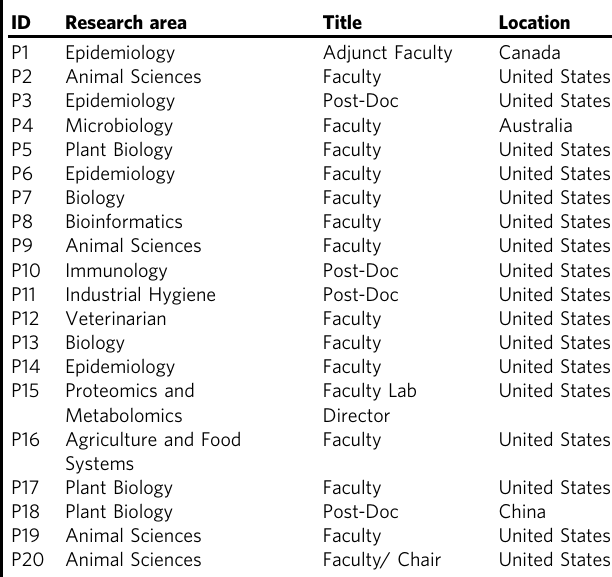
Table 1 Atomized description of the 20 participants. Their identi fi er, scienti fi c discipline, and academic